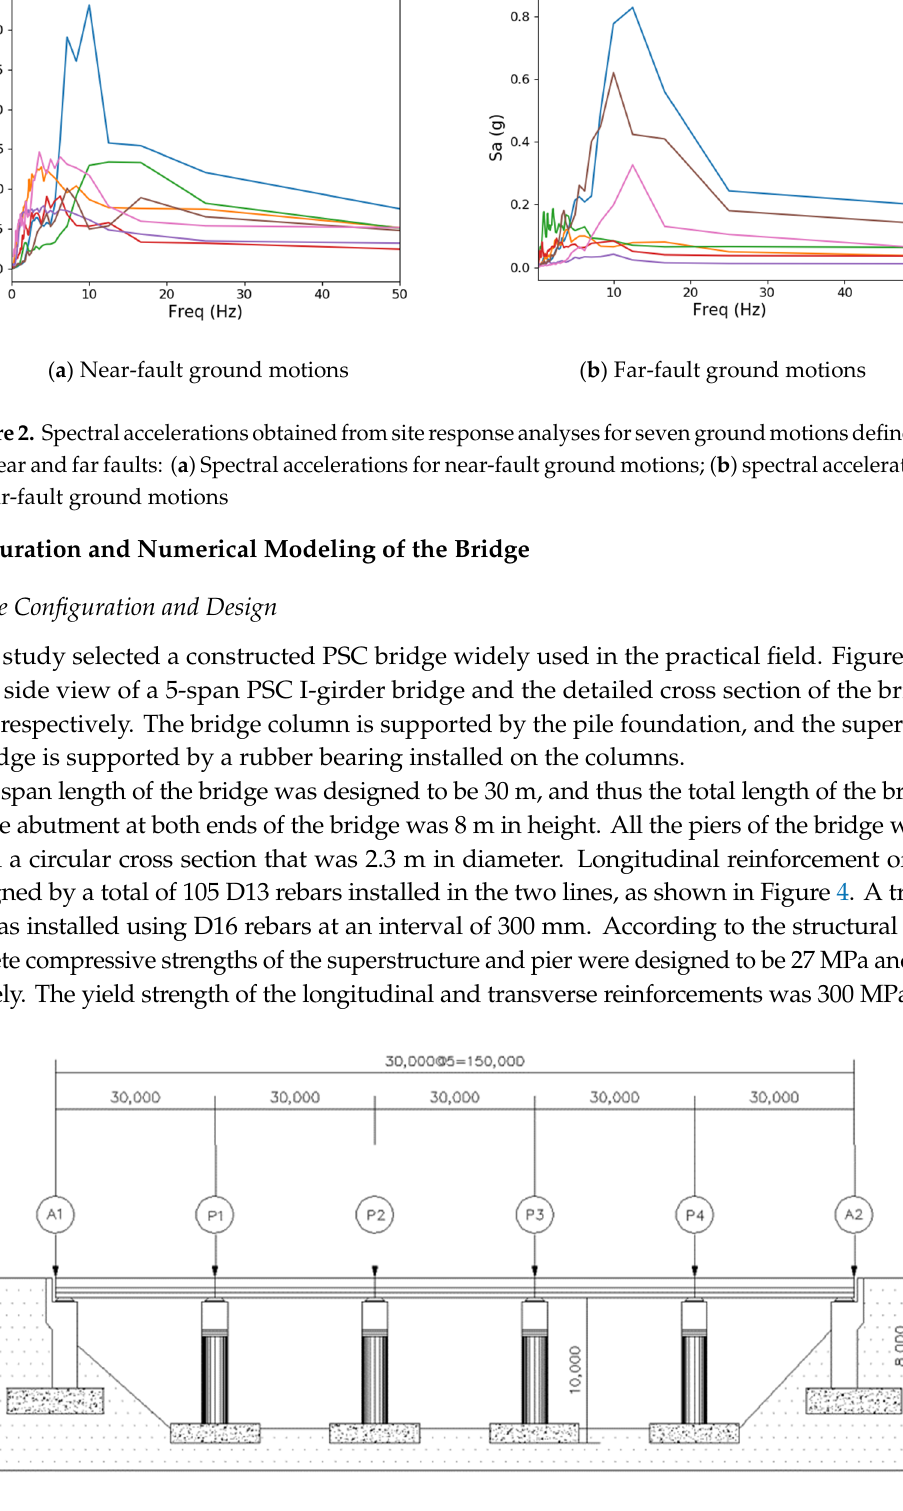
Figure 4. Cross section of the bridge and pier.